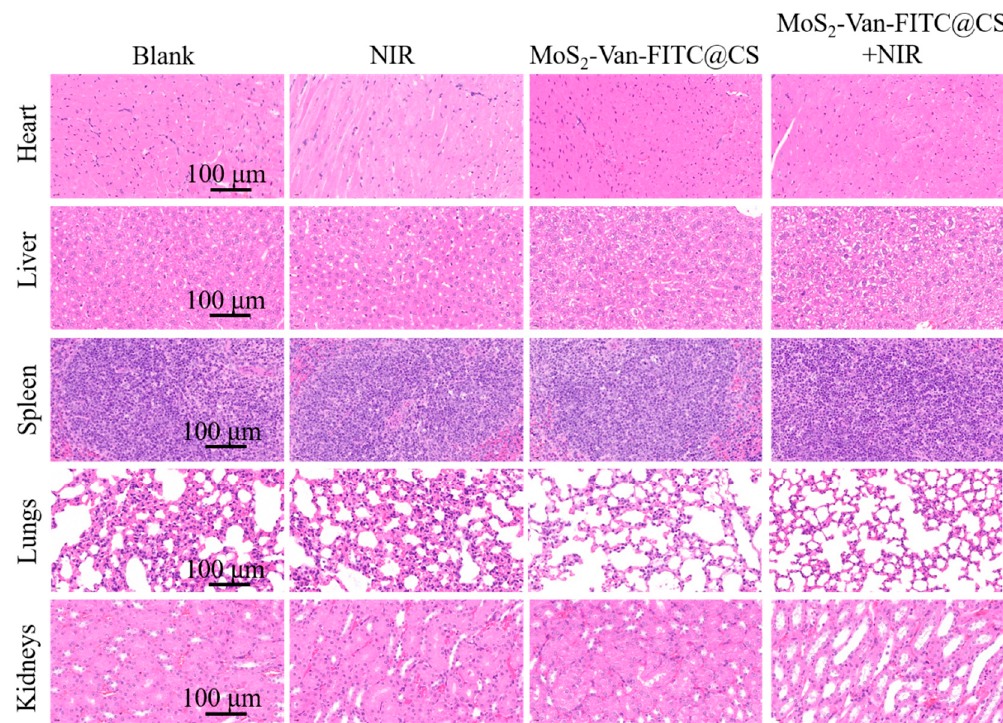
Figure 9. In vivo toxicity evaluation. The hematoxylin–eosin-stained images of major organs follow- ing different treatments of normal mice. Group 1 was the no treatment group, group 2 was the NIR irradiation (1.5 W/cm 2 , 6 min) group, group 3 was the MoS 2 -Van-FITC@CS group and group 4 was the MoS 2 -Van-FITC@CS + NIR (1.5 W/cm 2 , 6 min) group.